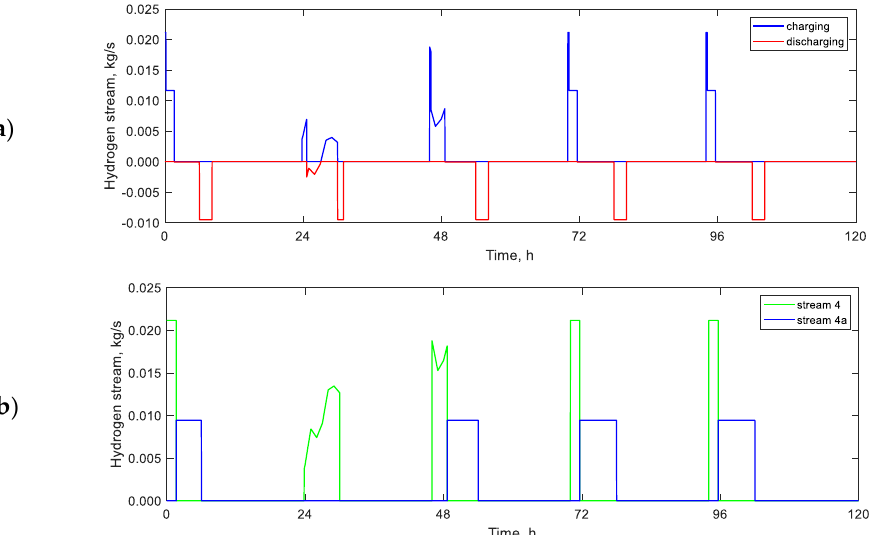
Figure 3. Graphical representations of the results for the hydrogen stream in the plant operation, simulated for 120 h: ( a ) charging and discharging the buffer; ( b ) the two operating states of the hydrogen generator that results from an adopted concept of the P2SNG system.